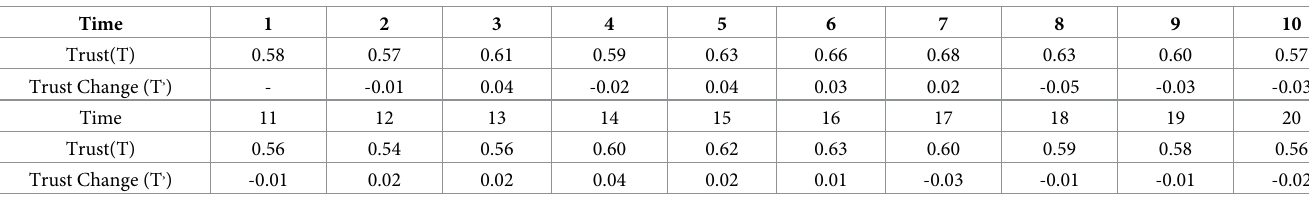
Table 4. Stable entity trust changes in Fig 2A.